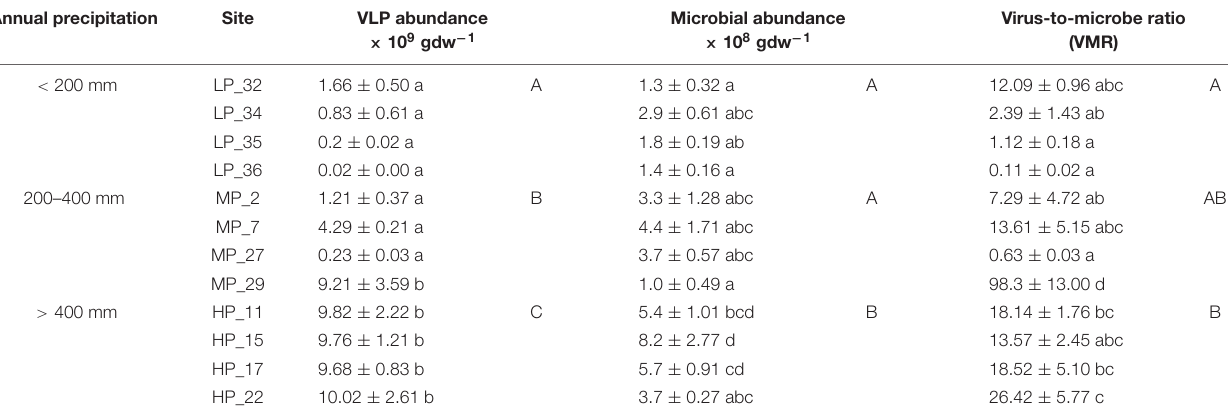
TABLE 1 | Virus-like particles (VLPs) and microbial abundance under different precipitation gradients.